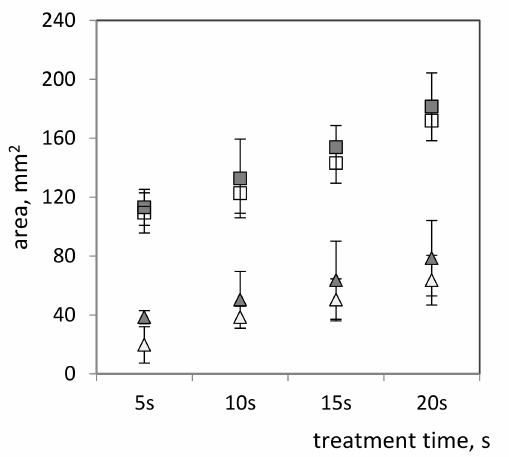
Figure 2. The area of sterilization zones as a function of treatment time at different wave powers (white markers—17 W; dark markers—20 W) and bacterial densities (triangle markers—90 × 10 5 cells/cm 2 ; square markers—3 × 10 5 cells/cm 2